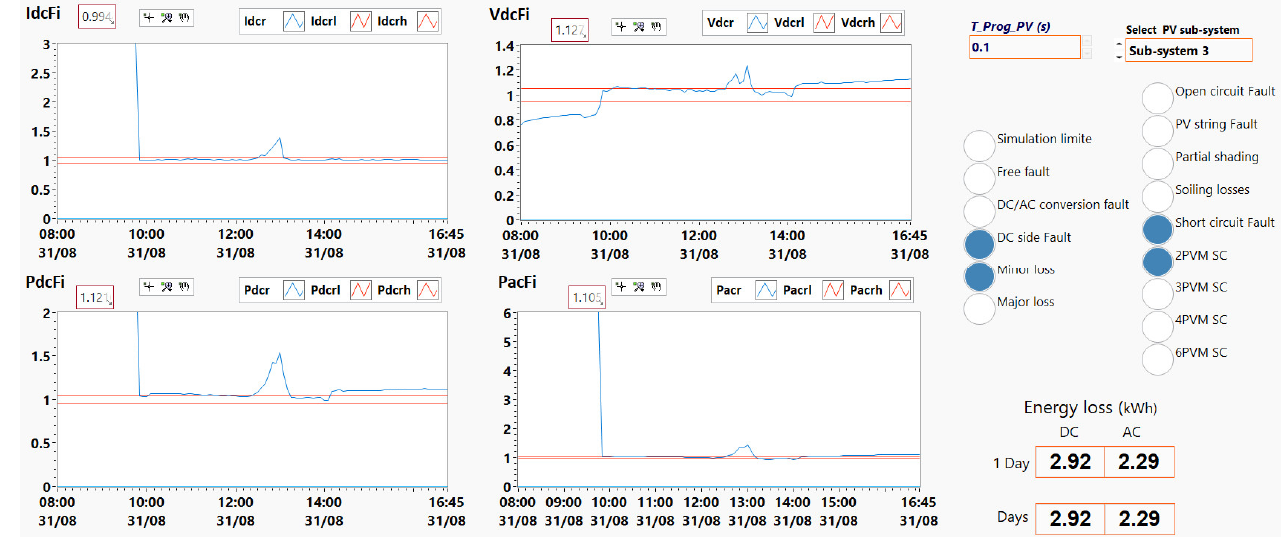
Figure 32. Identification of the two short-circuited PV modules.